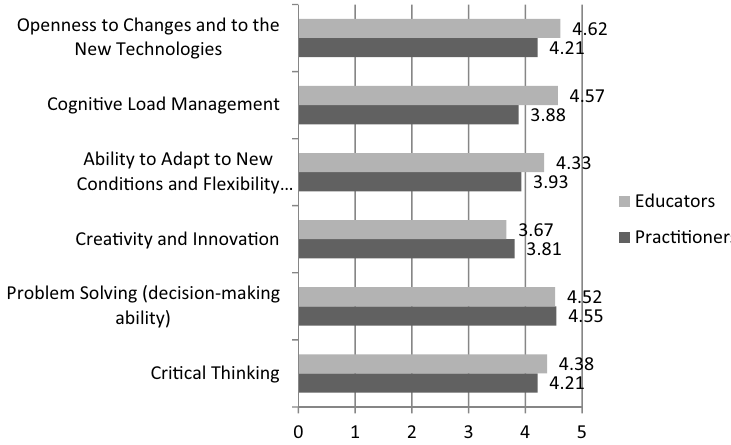
Figure 3: Cognitive competences in the opinion of practitioners and educators. Source: author ’ s own